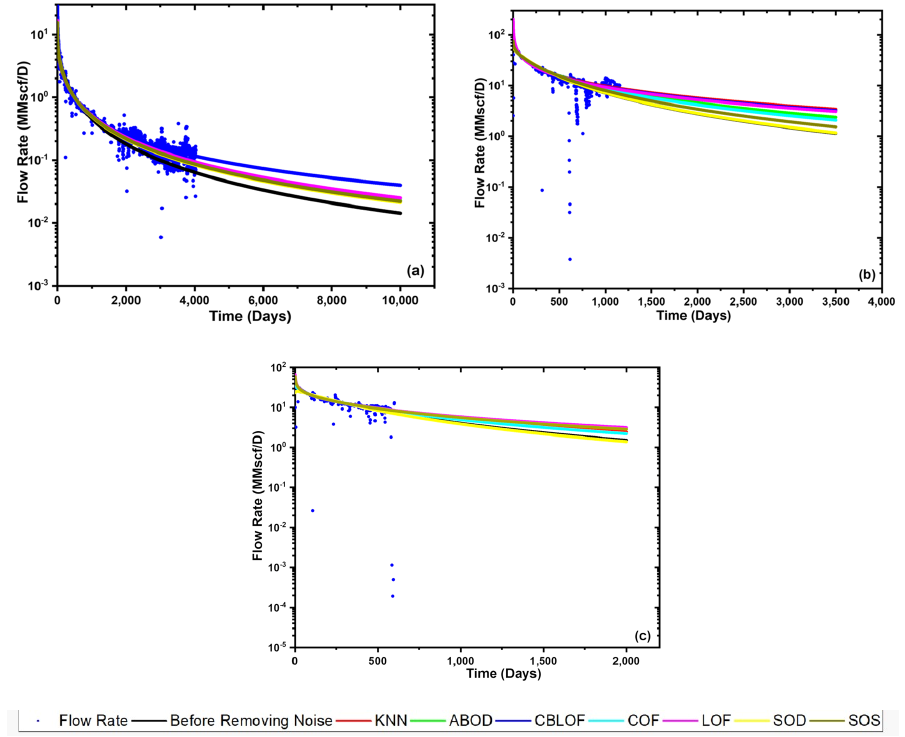
Figure 22. Applying HEHD decline model before and after removing noise using the seven OD algorithms for; ( a ) Well_12, ( b ) Well_29, and ( c ) Well_40.